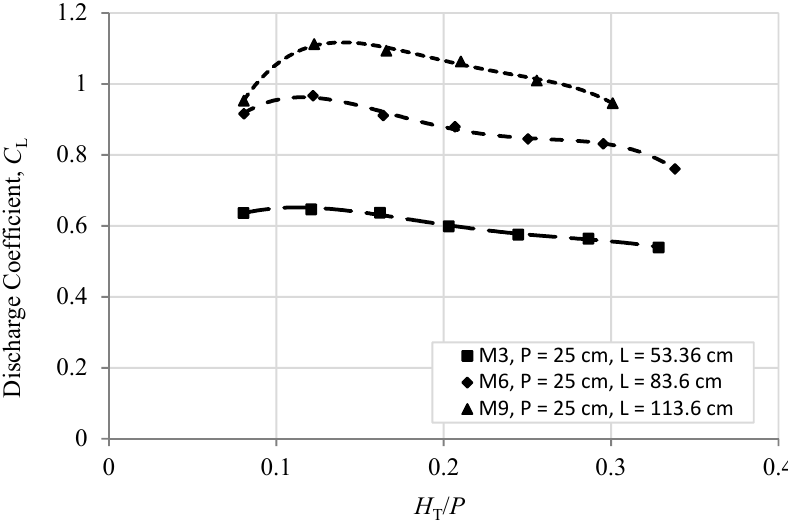
Figure 22. Discharge coefficient, C L , vs. H T /P for models M3, M6, and M9. Table 5. Changes in the total discharge and discharge coefficient due to the effective length.